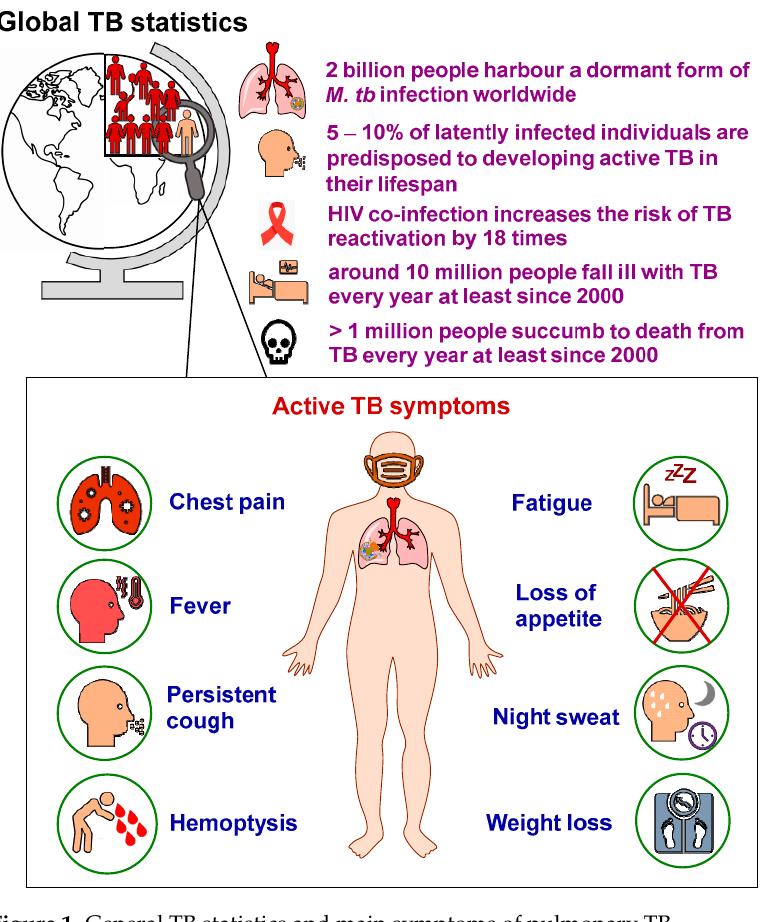
Figure 1. General TB statistics and main symptoms of pulmonary TB. Geographically, in 2021, the majority of people who developed TB were located in the WHO South-East Asian region (45%), followed by the WHO African region (23%) and the WHO Western Pacific region (18%). Four countries accounted for more than half of the global TB burden: the two WHO South-East Asian countries, India (28%) and Indonesia (9.2%), in addition to the two WHO Western Pacific countries, China (7.4%) and the Philippines (7.0%) [2]. Although the fraction of people with LTBI predisposed to TB reactivation is seemingly small, roughly 10 million people fall ill with TB annually at